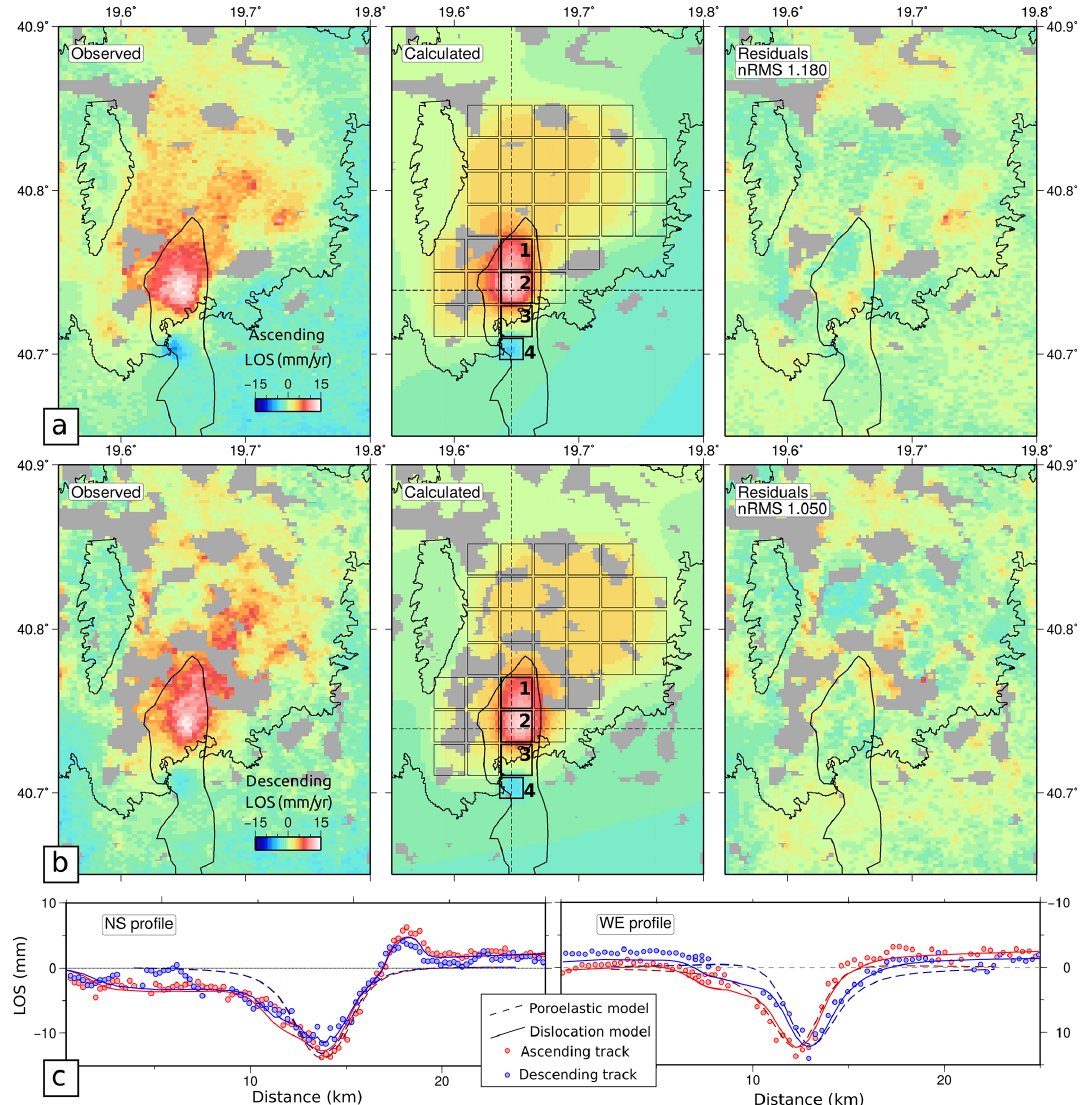
Figure 8. (a, b) Calculated LOS velocity maps (left) are compared with predicted ones, produced by planar crack Okada-type dislocations in a homogeneous elastic half space (center), for both the ascending (a) and descending (b) tracks. Residuals are plotted in the right panels. Gray dashed lines in the central panels show the locations of profiles at bottom. Numbered dislocations contoured in bold are those inside the oil field (see text for details). (c) North–south and west–east profiles with observed (dots) and predicted (lines) velocities using either the planar-cracks model presented above (plain line) or a 2D poroelastic axisymmetric reservoir (dashed line) (see text for details). Velocities on the ascending and descending tracks are shown in red and blue, respectively. Note that the 2D poroelastic model predicts nearly LOS- independent velocities in the N–S